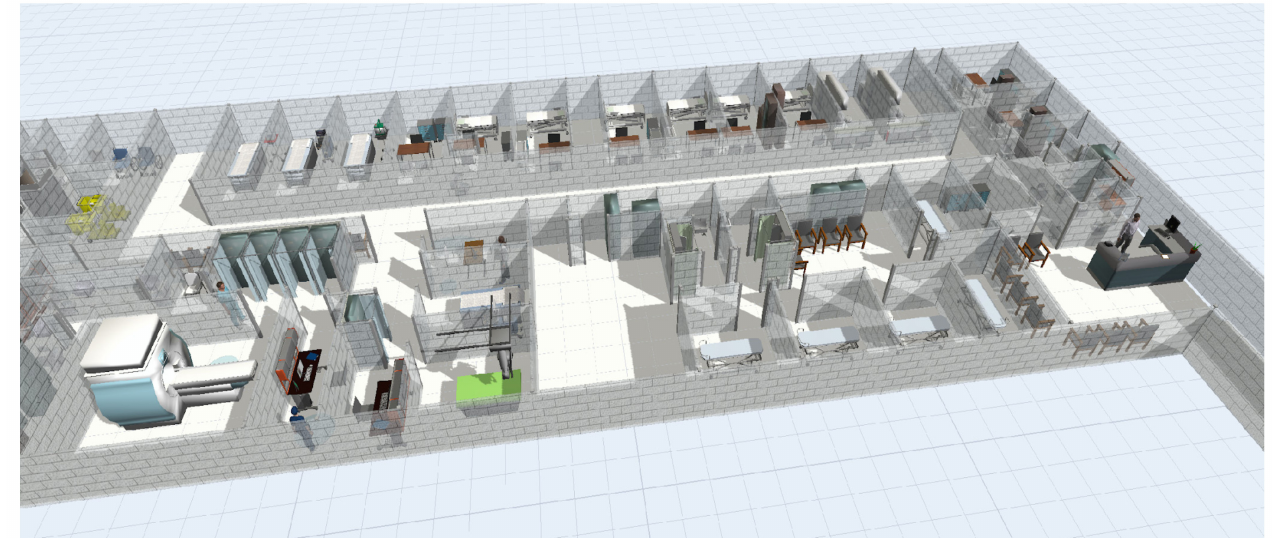
Figure 3. 3D Baseline model of the GSD